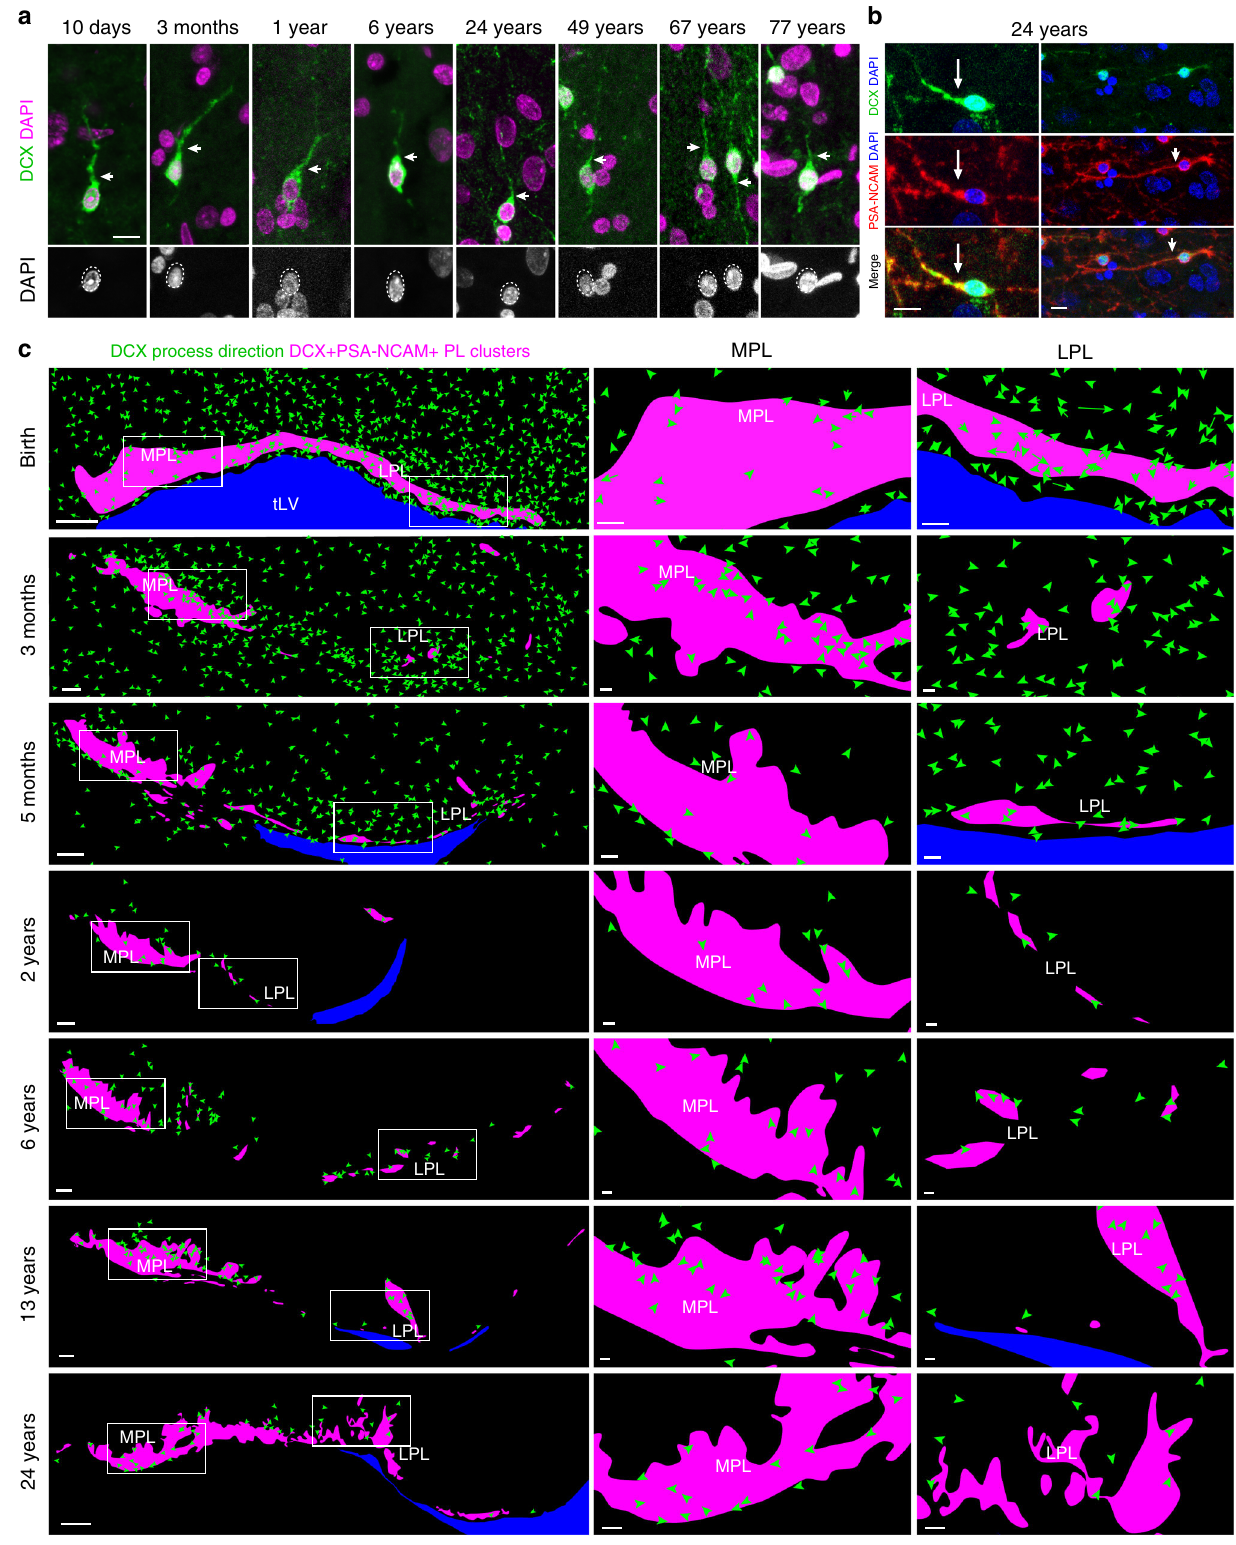
Fig. 7 DCX + PSA-NCAM + neurons with migratory characteristics in the postnatal PL. a (Top) Examples of DCX + cells with morphology similar to migratory neurons (arrows) in the PL from 10 days postnatal to 77 years of age. (Bottom) DAPI + nuclei of the DCX + cells above showing varying degrees of nuclear elongation (dotted circles). b DCX + PSA-NCAM + cells in the 24-year-old MPL with processes (arrows) and elongated nuclei (left two columns) or rounded nuclei (right column). c Maps of the orientations of DCX + cells with migratory characteristics near the PL from 38 GW to 24 years. (Right) Higher magni fi cation of the MPL and LPL. Arrow direction and length indicate the orientation and length of putative leading processes. Scale bars: 500 µ m ( c left), 100 µ m ( c middle, c right), 10 µ m ( a , b